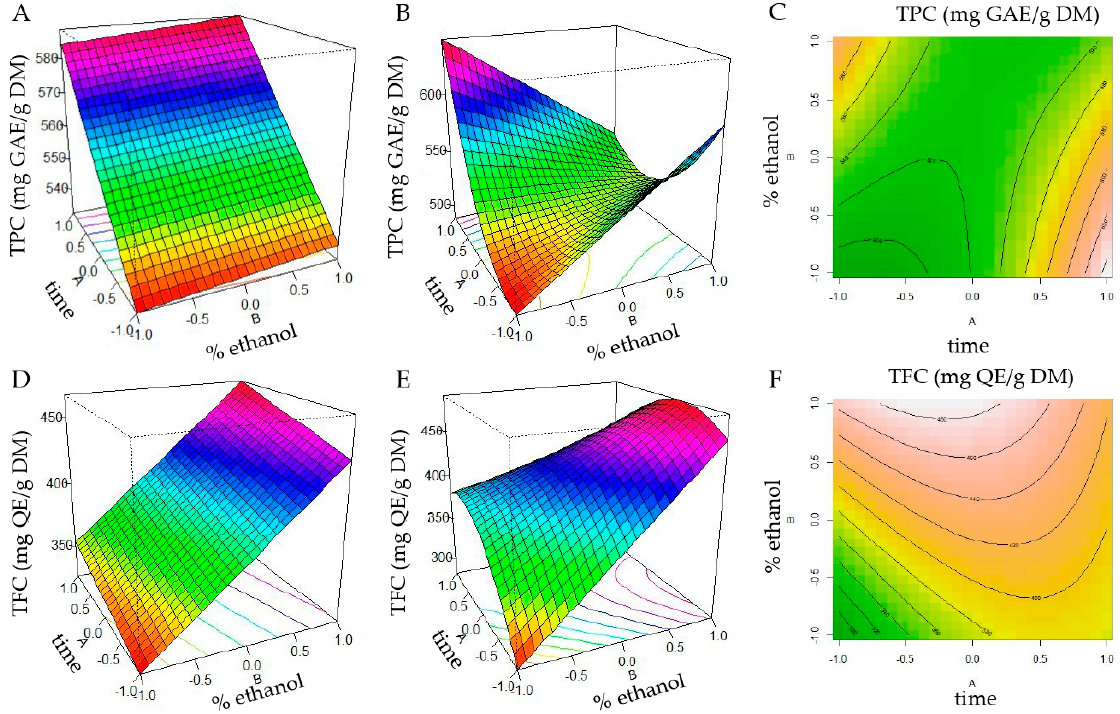
Figure 2. Response surface and contour plots showing the interactive effects of extraction independent variables on the total phenolic content (TPC) and total flavonoid content (TFC). ( A ) Model fitted to first order model for TPC; ( B ) Model fitted to second-order model for TPC; ( C ) contour plots for TPC; ( D ) Model fitted to first order model for TFC; ( E ) Model adjusted to second-order model for TPC; ( F ) Contour plots for TPC.